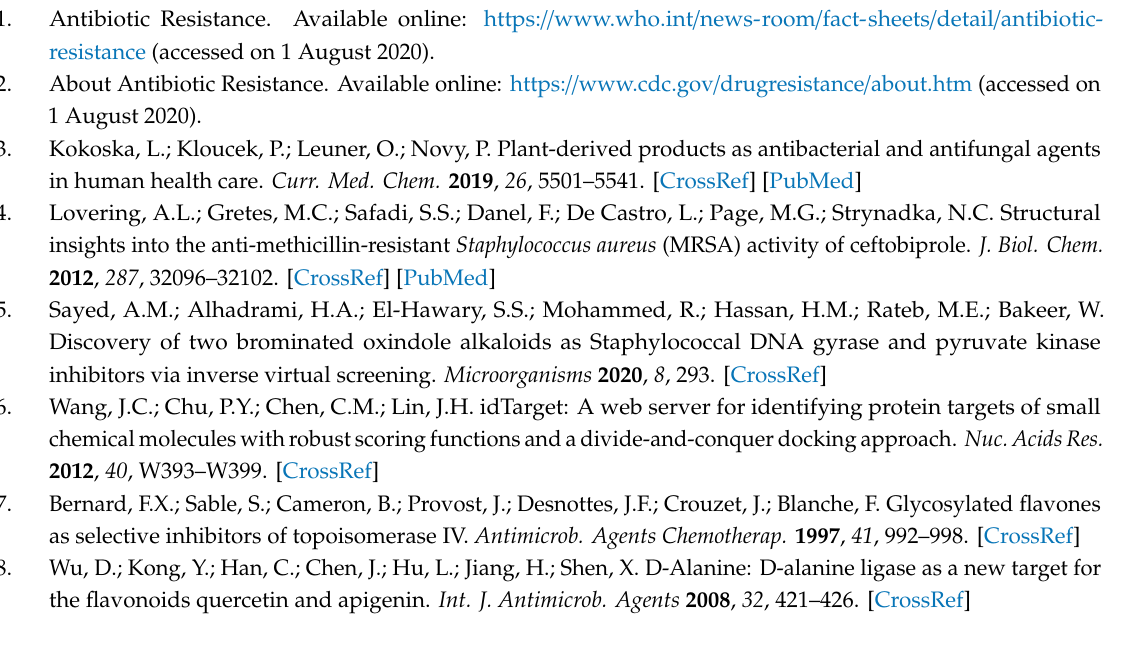
Figure S1: RMSDs of PBP2a-ligand complexes and the ligands. ( A ) apigenin (4), ( B ) chrysin (5), ( C ) hesperetin (6); Figure S2: RMSDs of PBP2a-ligand complexes and the ligands. ( A ) rutin (10), ( B ) diosmin (11), ( C ) hesperidin (12), ( D ) silibinin A (13). Table S1: List of the potential anti-MRSA targets suggested by idTarget, Table S2: List of compounds that predicted to be possible inhibitors for certain Staphylococcal protein